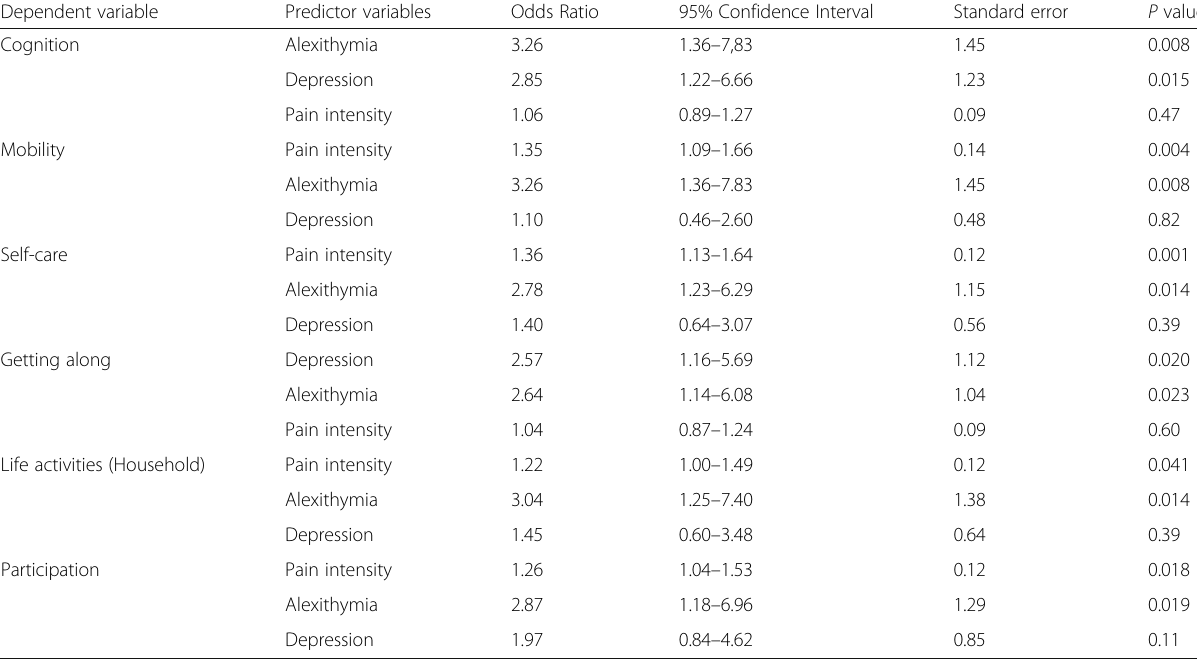
Table 4 Association between WHODAS disability domains and Pain Intensity, Depression and Alexithymia Dependent variable Predictor variables Odds Ratio 95% Confidence Interval Standard error P value